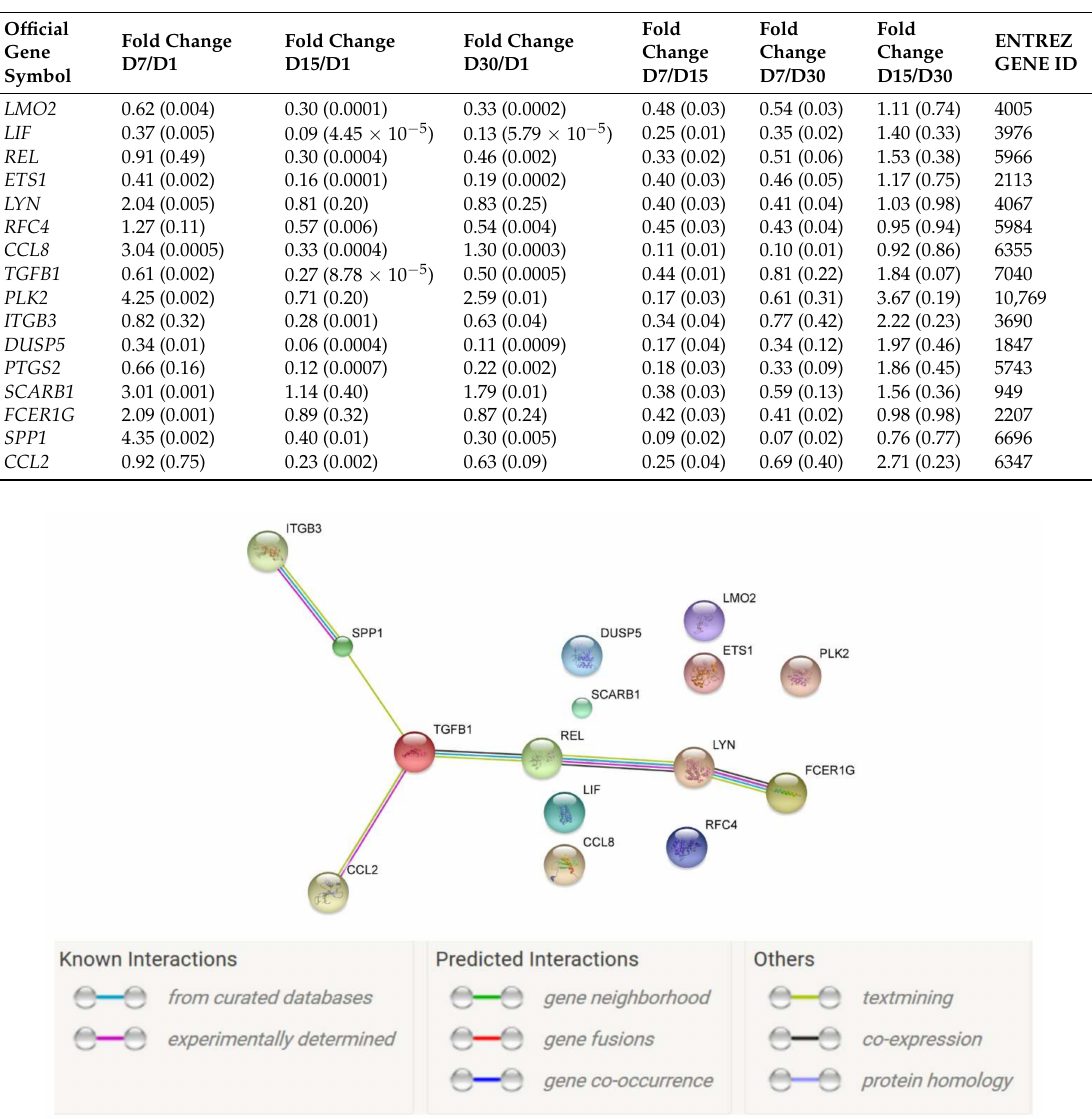
Table 1. The official gene symbols, fold changes, and adjusted p . values of the differently expressed genes that belong to the “positive regulation of metabolic process” and “regulation of homeostatic process”. Adjusted p -values are presented in brackets next to their respective fold changes.